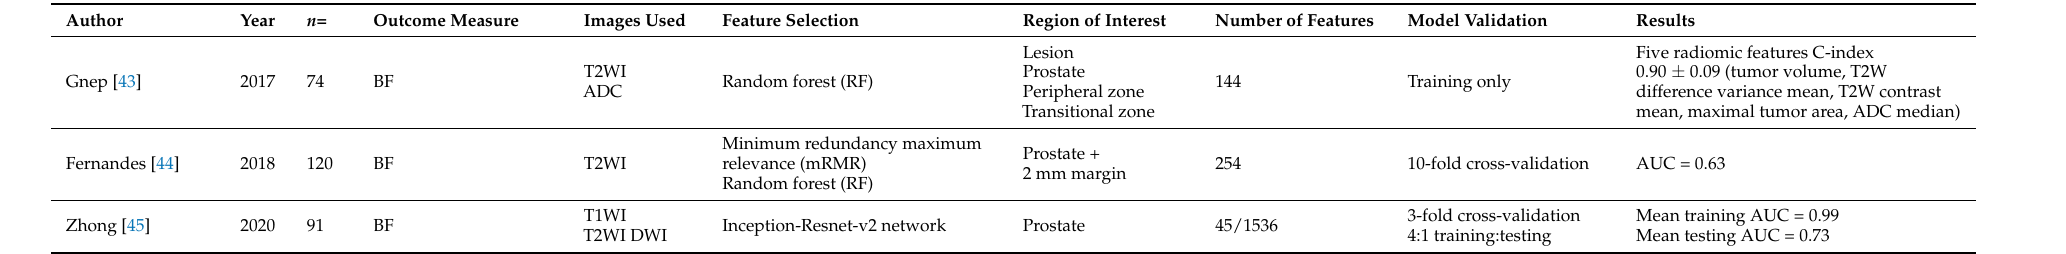
Table 4. Summary of studies utilizing MRI-derived radiomic models to predict biochemical failure following radiation